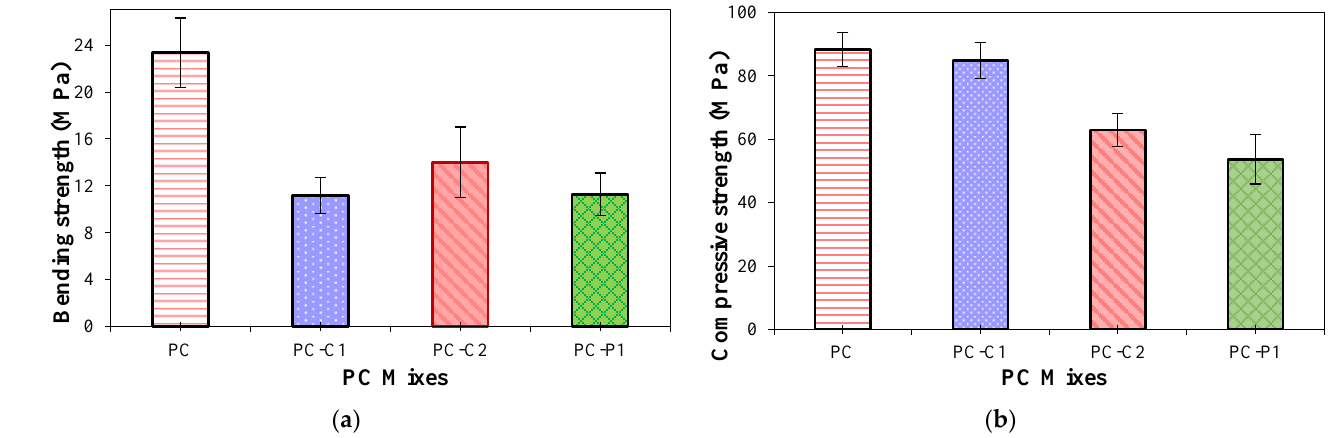
Figure 9. Bending and compressive resistances of different PC sets: ( a ) Flexural strength, ( b ) Com- pressive strength.